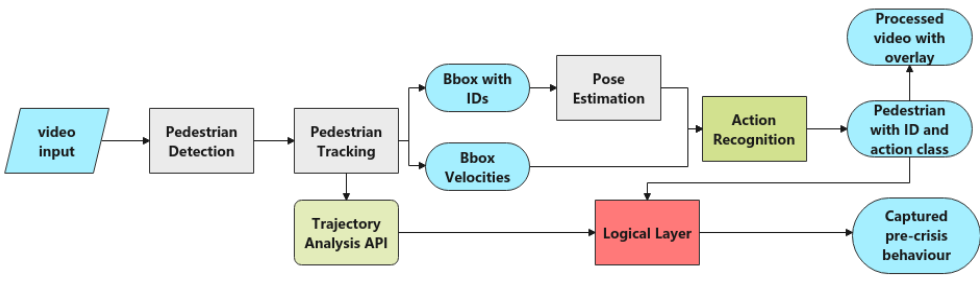
Figure 1. Structure of proposed visual processing